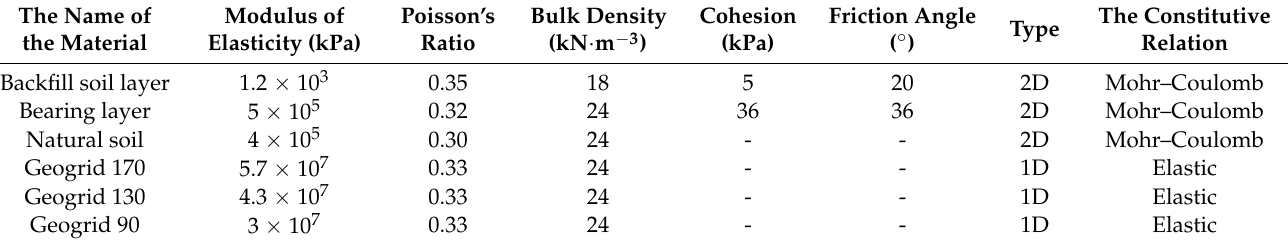
Table 1. Material property parameter